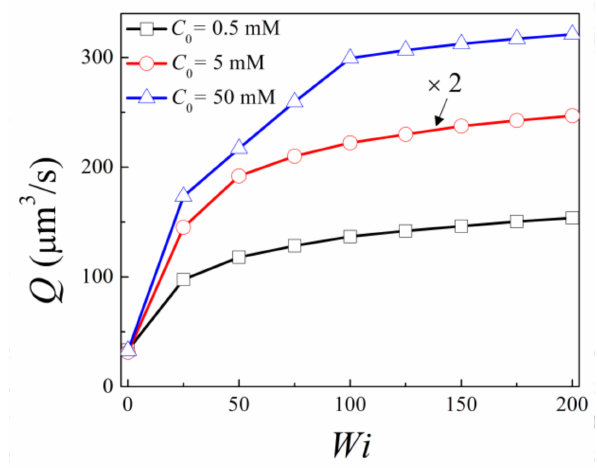
Figure 3. Variation of volume flow rate with the Weissenberg number for bulk concentration C 0 = 0.5 mM, 5 mM, and 50